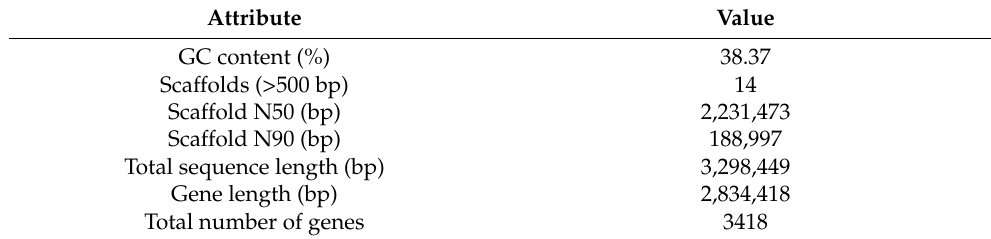
Table 3. Genome statistics of Rummeliibacillus sp. TYF-LIM-RU47.